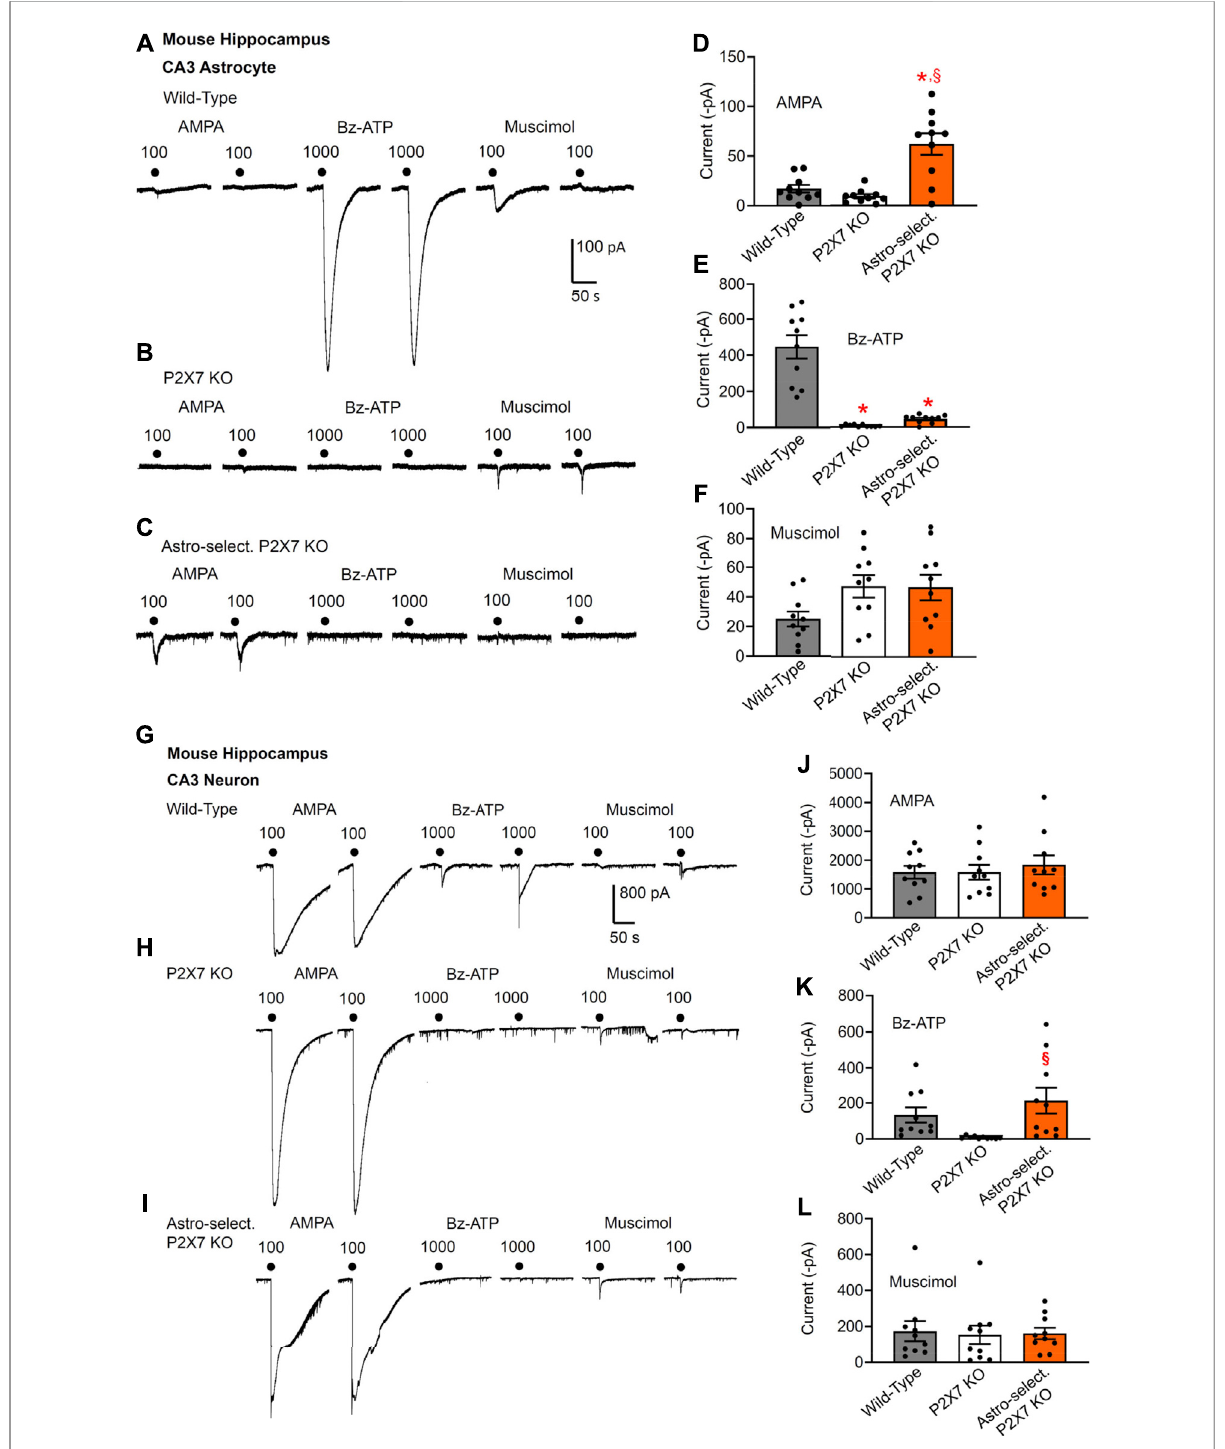
FIGURE 2 Current responses to ionotropic receptor agonists in the CA3 area of the mouse hippocampus. Hippocampal brain slices of 10 – 15 day-old wild-type mice, as well as mice whose P2X7Rs were genetically deleted either in all cells, or selectively in astrocytes. AMPA (100 µM), Bz-ATP (1,000 µM)and muscimol(100 µM)were locally applied every 3 min, each agonisttwice. (A – F) The membranecurrents wererecordedin astrocytes by means of the whole-cell patch-clamp method at a holding potential of − 80 mV. Representative tracings in (A – C) . Effects of AMPA (D) , Bz- ATP (E) , and muscimol (F) in the three types of animals. Mean ± SEM current amplitudes. * p < 0.05; statistically signi fi cant difference from results in wild-type animals (AMPA, F 2,18 = 21.61, p = 0.0002; Bz-ATP, F 2,18 = 42.03, p < 0.0001; two-way ANOVA followed by the Tukey ’ s test). § p < 0.05;